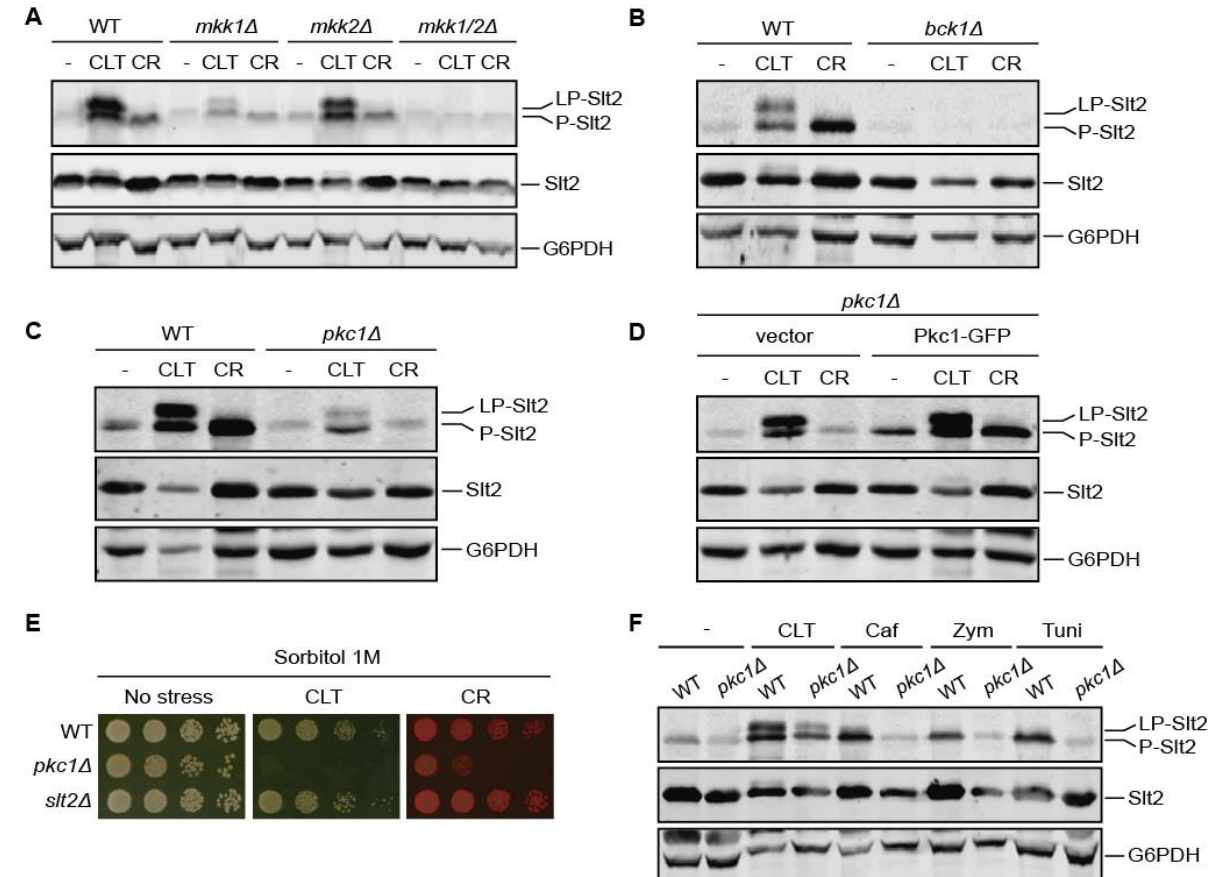
Figure 3. Involvement of protein kinases operating at the CWI pathway in clotrimazole-induced signaling to Slt2. ( A – C ) Western blotting analysis of extracts of BY4741 (WT) and the indicated isogenic mutant strains. Cells were cultured without stimulus (-), with 50 µg/mL of CLT, or with 30 µg/mL of CR for 4 h at 24 °C. Dually phosphorylated Slt2, Slt2 protein, and G6PDH (as a loading control) were detected with anti-phospho-p44/42, anti-Mpk1, and anti-G6PDH, respectively. ( D ) Western blotting analysis of pkc1∆ cells transformed with either the empty vector pRS316 or with pVD67 (Pkc1-GFP). Cells were cultured and proteins were detected as described in ( A – C ). ( E ) Sensitivity of BY4741 (WT) and the indicated mutant strains to CLT and CR per drop dilution growth assay. Ten-fold serial dilutions of cell suspensions were spotted onto YPD plates supplemented with 1 M sorbitol in the absence (no stress) or presence of 1 µg/mL of CLT or 30 µg/mL of CR, and incubated at 30 °C for 72 h. A representative assay from three independent experiments is shown. ( F ) Western blotting analysis of extracts of BY4741 (WT) and its isogenic pkc1Δ strain. Cells were cultured without stimulus (-), with 50 µg/mL of CLT, 8 mM of caffeine (Caf), 0.4 U/mL of zymolyase (Zym), or 5 µg/mL of tunicamycin (Tuni) for 2 h at 24 °C. Proteins were detected as described in ( A – C ). Representative blots from two independent experiments are shown.